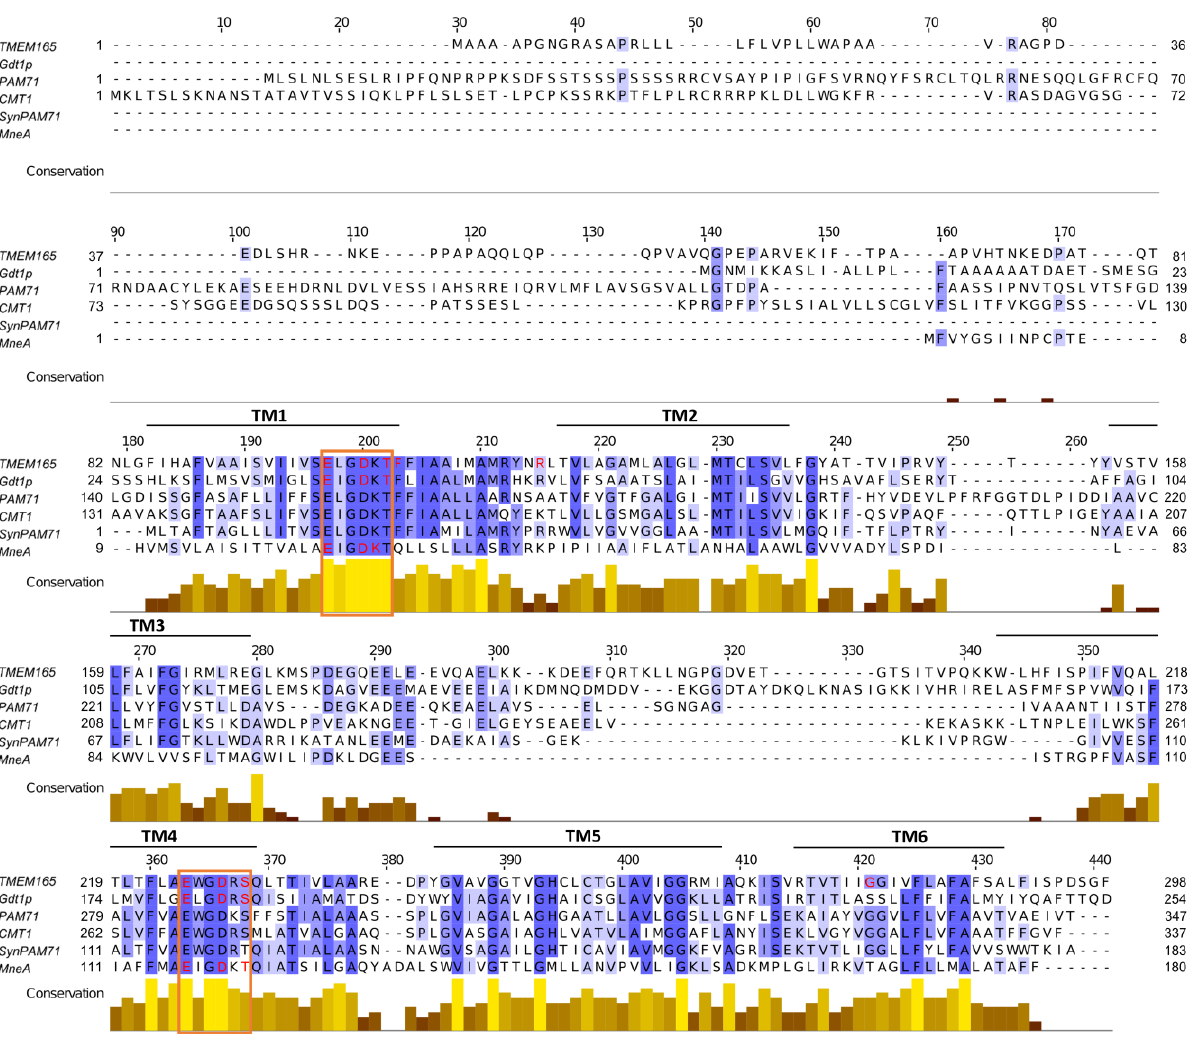
FIGURE 3: Multiple alignment of the amino acid sequences of the studied UPF0016 members. The alignment was carried out using Clustal Omega and visualized in Jalview. Residues are shaded in blue depending on their conservation. The conservation histogram provides quanti- tative evaluation of the degree of conservation of the physico-chemical properties of the amino acids at the corresponding position. Puta- tive transmembrane spans predicted by TMAP are indicated above the sequences (TM1 – TM6). The highly conserved UPF0016 motifs are framed in orange. Residues identified as altering the protein stability, localization, and/or activity are highlighted in OPEN ACCESS | www.microbialcell.com